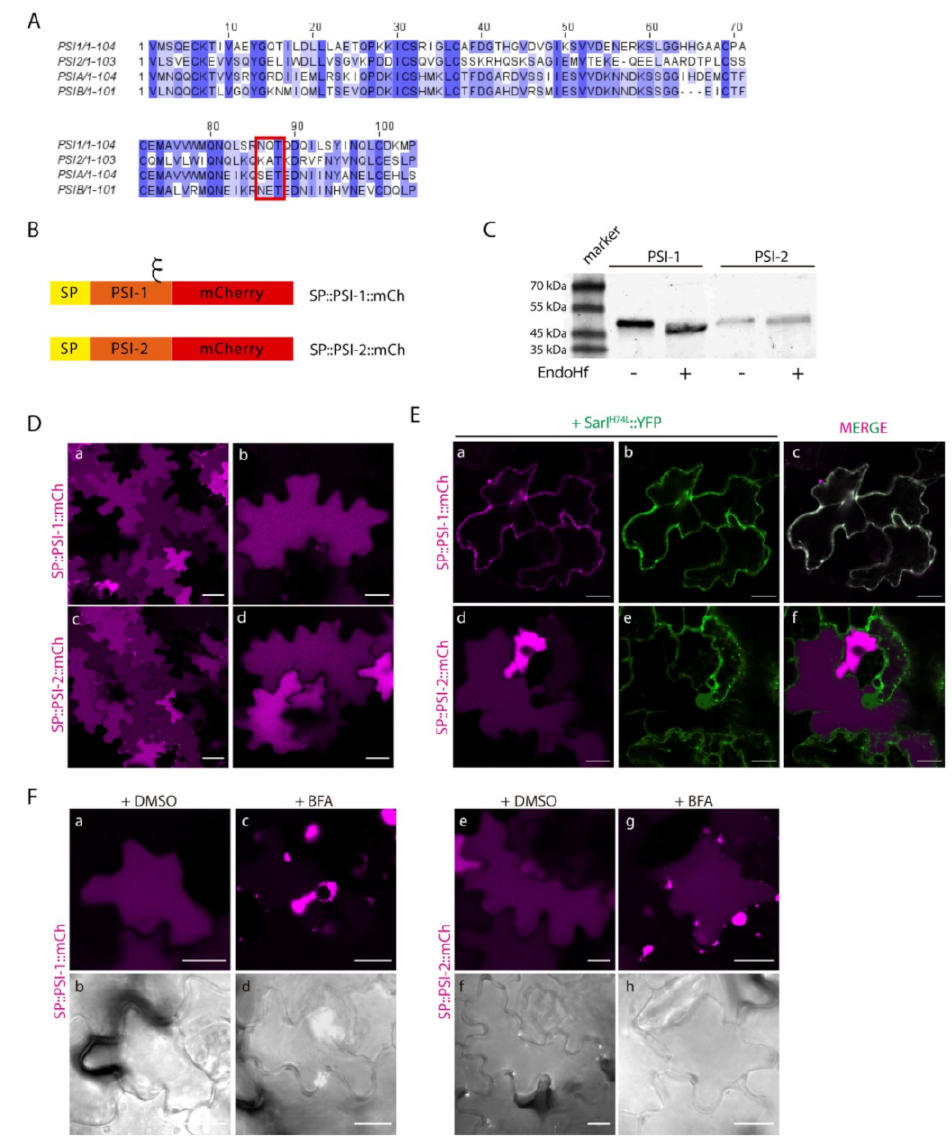
Figure 6. Expression of Soybean PSIs in N. tabacum epidermal cells presents the same dichotomy as cardosins’. ( A ) Alignment of Soybean (PSI-1 and PSI-2) and cardosin (PSI-A and PSI-B) PSIs. The sequence conservation is not high, but PSI-1 is predicted to be glycosylated as PSI-B–red box. ( B ) Schematic representation of the two constructs designed for this experiment. ( C ) Western blot obtained after an endoglycosidase H assay for PSI-1 and PSI-2, where a shift-down in the band corresponding to PSI-1 is evident. ( D ) Vacuolar localization of both constructs in tobacco epidermal cells: (a–b) SP::PSI-1::mCh, (c–d) SP::PSI-2::mCh. ( E ) Co-expression of SP::PSI-1::mCh (a–c) and SP::PSI-2::mCh (d–f) with the dominant negative mutant SarI H74L ::YFP shows di ff erences in the sensitivity of the mutants to this blockage. ( F ) Expression of SP::PSI-1::mCh (c–d) and SP::PSI-2::mCh (g–h) in tobacco cells followed by Brefeldin A treatment. DMSO was used as a negative control (a–b, e–f). DIC images of the same cells were also acquired to evaluate cell morphology. All observations and images were acquired 3 days post-infiltration. Images were analyzed and processed using ImageJ / Fiji software. Scale bars: ( D )—left panels, 50 µ m, right panels, 20 µ m; ( E )—20 µ m; ( F )—20 µ